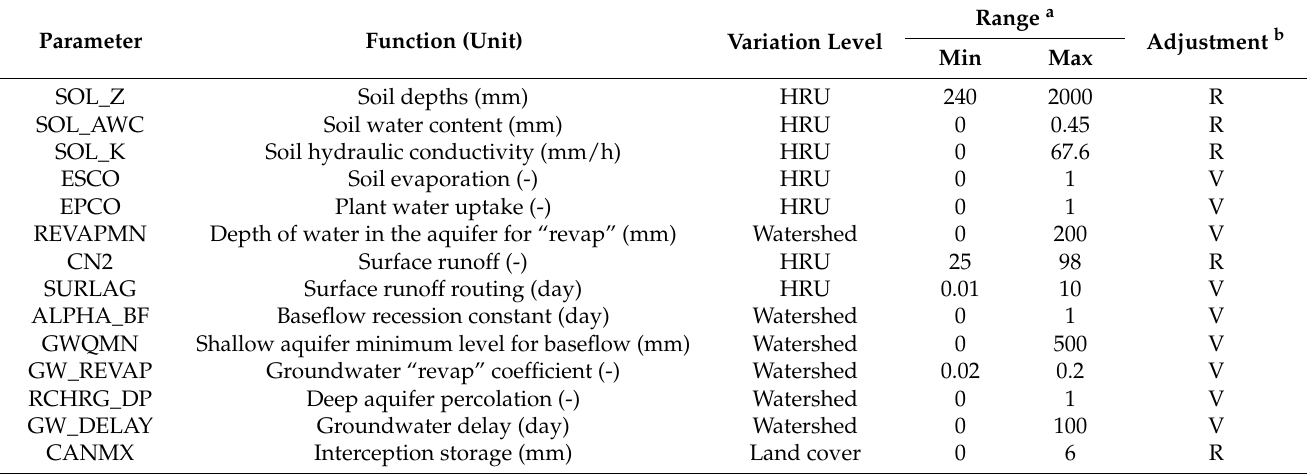
Table 2. The list of SWAT parameters used during model calibration with their